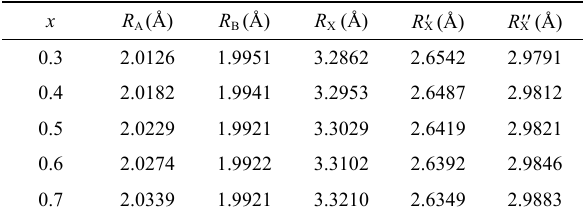
Table 3 R A , R B , R X , R X  , and R X  for Mg 1– x Zn x Fe 2 O 4 ( x = 0.3, 0.4, 0.5, 0.6, and 0.7)